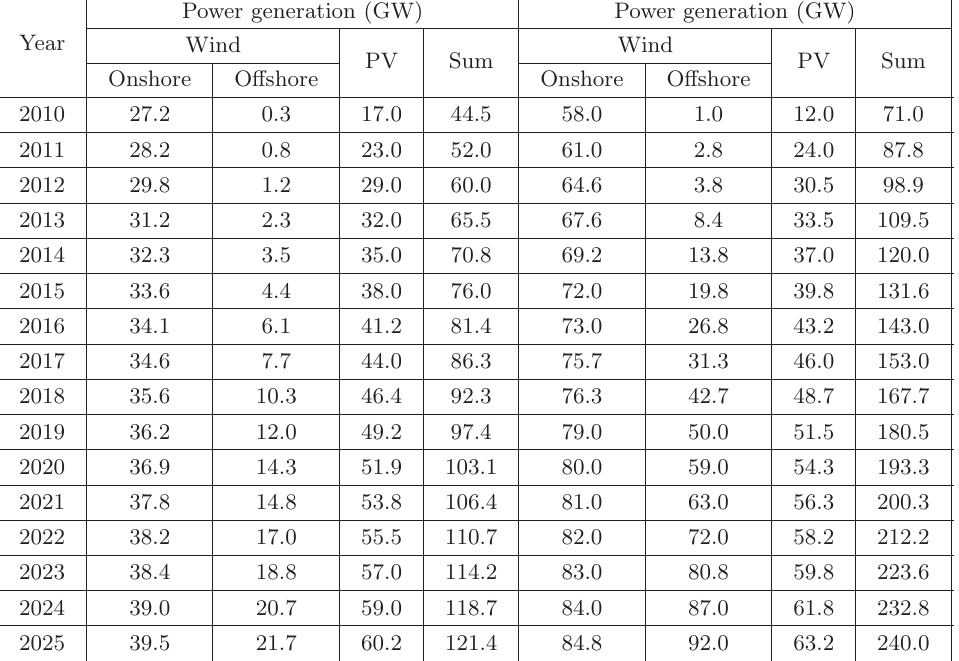
Table IV. – Projected installed power capacity and energy output of wind and solar resources in Germany till 2025 [32]